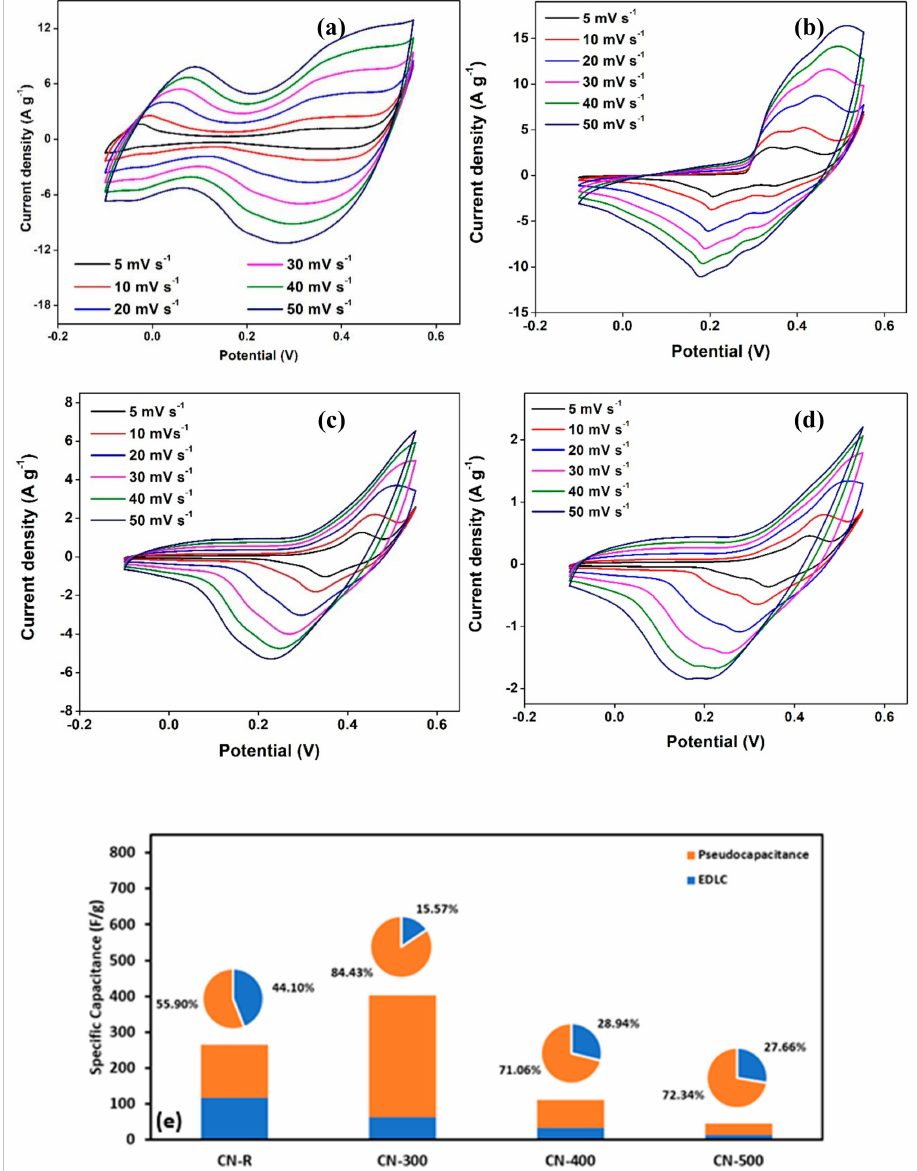
Figure 7. Cyclic voltammetry (CV) results of ( a ) CN-R, ( b ) CN-300, ( c ) CN-400, ( d ) CN-500, and ( e ) surface and diffusion contributions to the